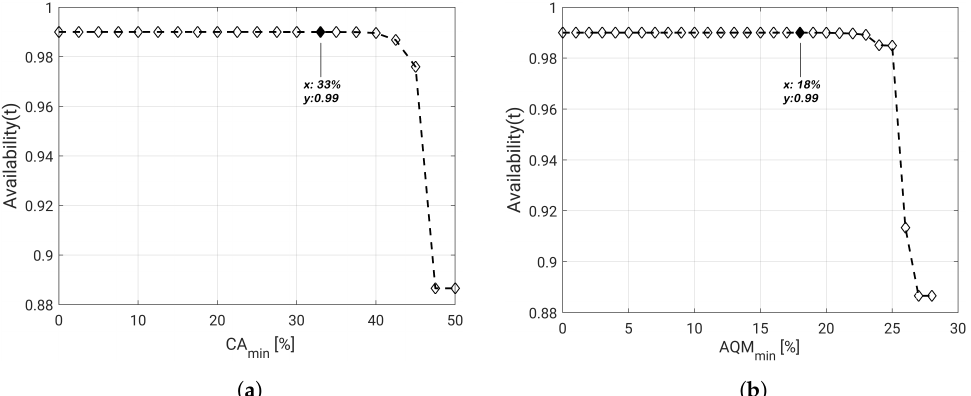
Figure 12. Impact of ( a ) CA min and ( b ) AQM min on dependability evaluation.